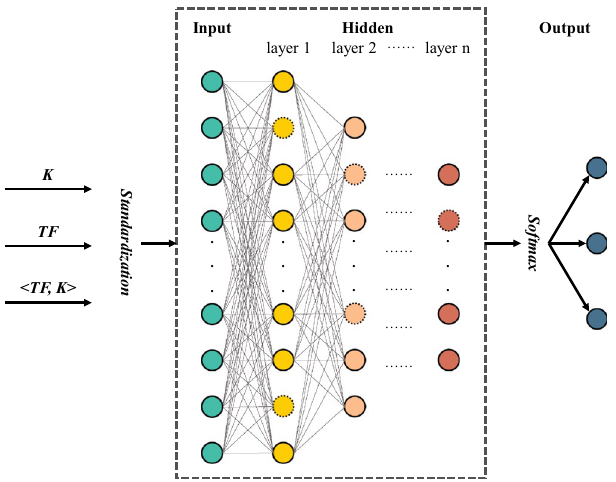
Figure 2. Artificial neural network structure. Visualization of neural network learning. After max–min scaling the input variables, the contact features can be learned by a fully-connected neural network. During model training, some neurons (dotted dots) are temporarily discarded from the network according to a certain probability, so that the network can avoid over fitting and be generalized